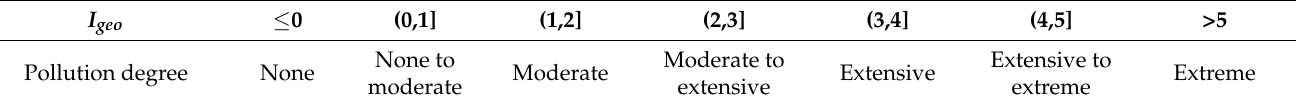
Table 2. Geo-accumulation index and classification [10].